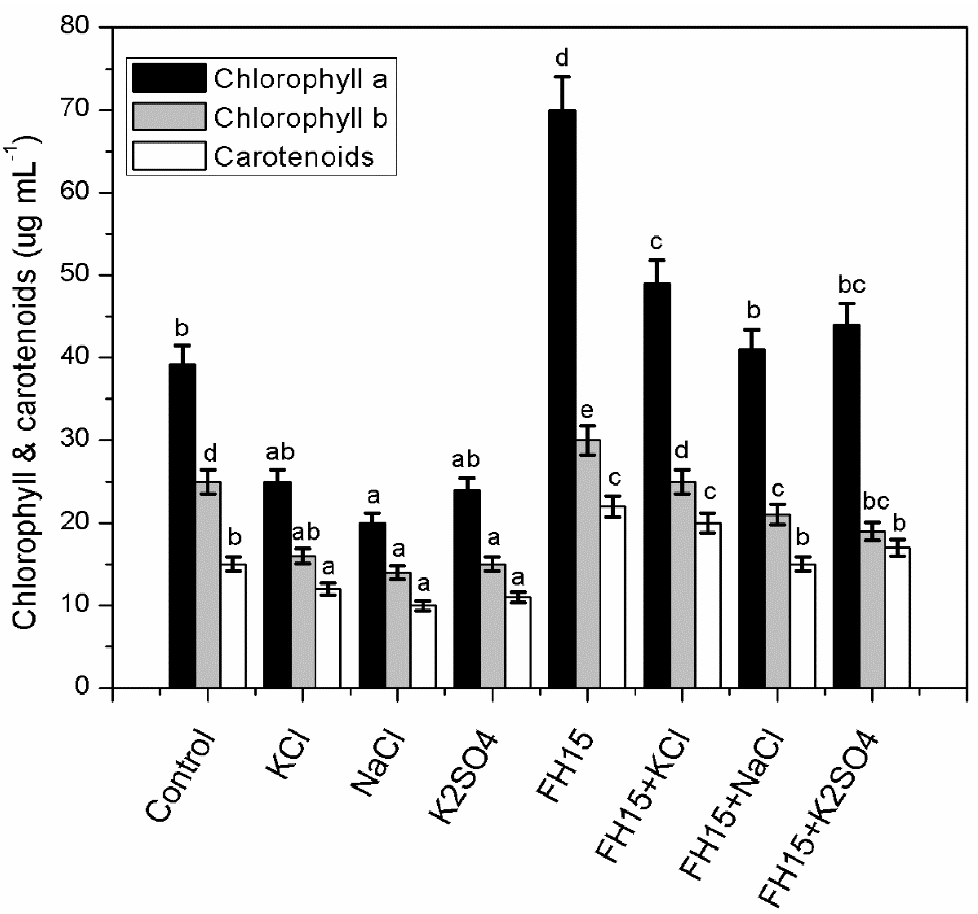
Figure 3. Impact of various salts on total chlorophyll and carotenoids contents of maize with or without endophytic fungal strain C. membranifaciens FH15. The bars represent mean with ± SE and the different letters on the bars represent significance at p = 0.05.